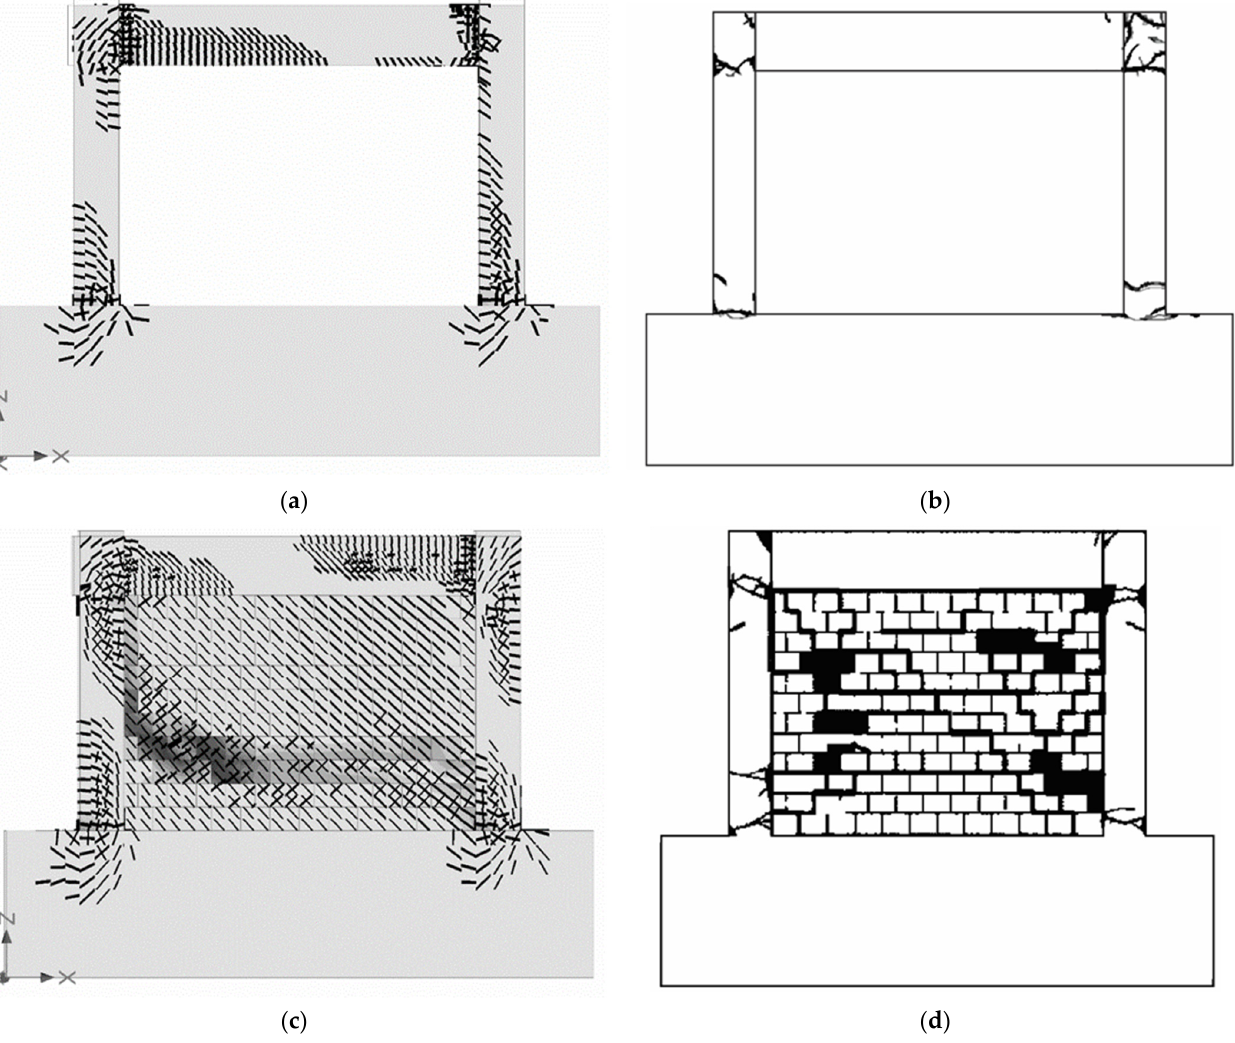
Figure 9. Comparison of failure mode: ( a ) Open Frame—meso model; ( b ) Open Frame—Kakaletsis’s experiment; ( c ) Infilled Frame—meso model; ( d ) Infilled Frame—Kakaletsis’s experiment.